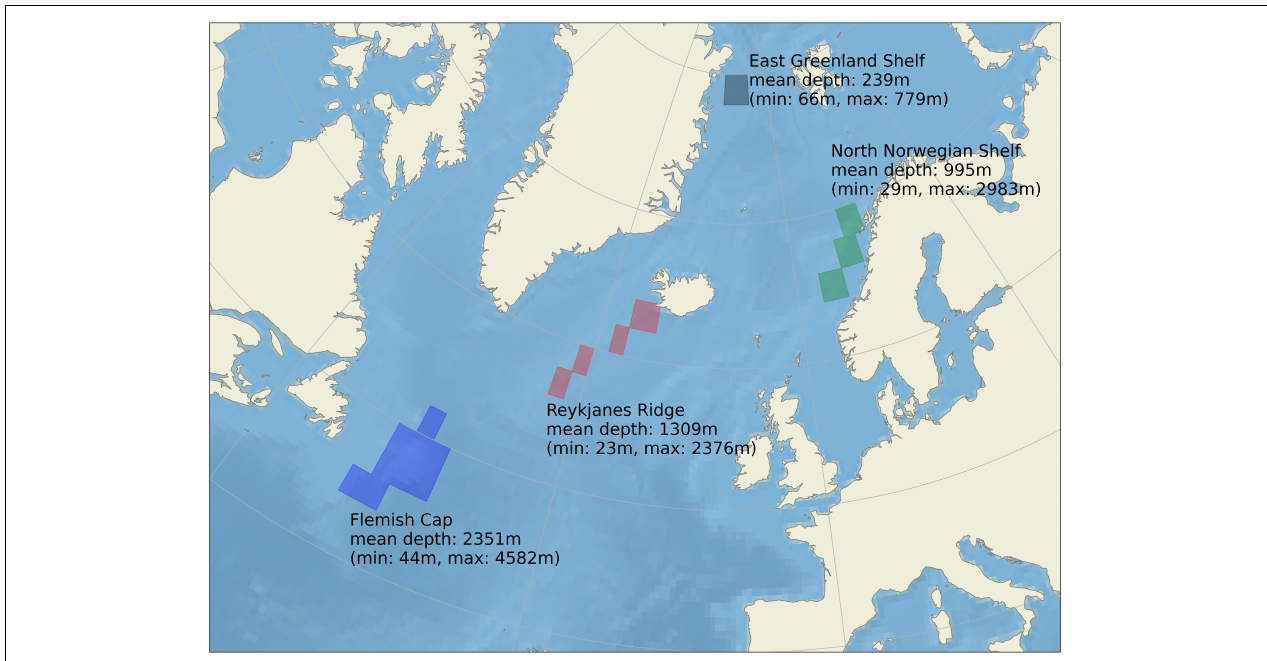
FIGURE 3 | The four areas of sponge habitat that are the focus of this paper. The minimum, maximum and mean depth for each study site based on the model bathymetry, are shown together with the geographical